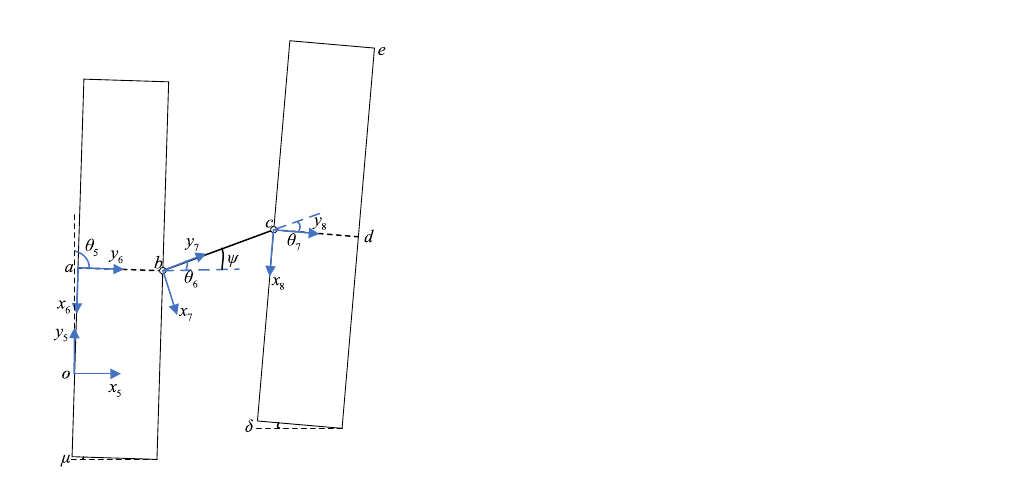
Figure 10. D–H matrix coordinate system between leading hydraulic